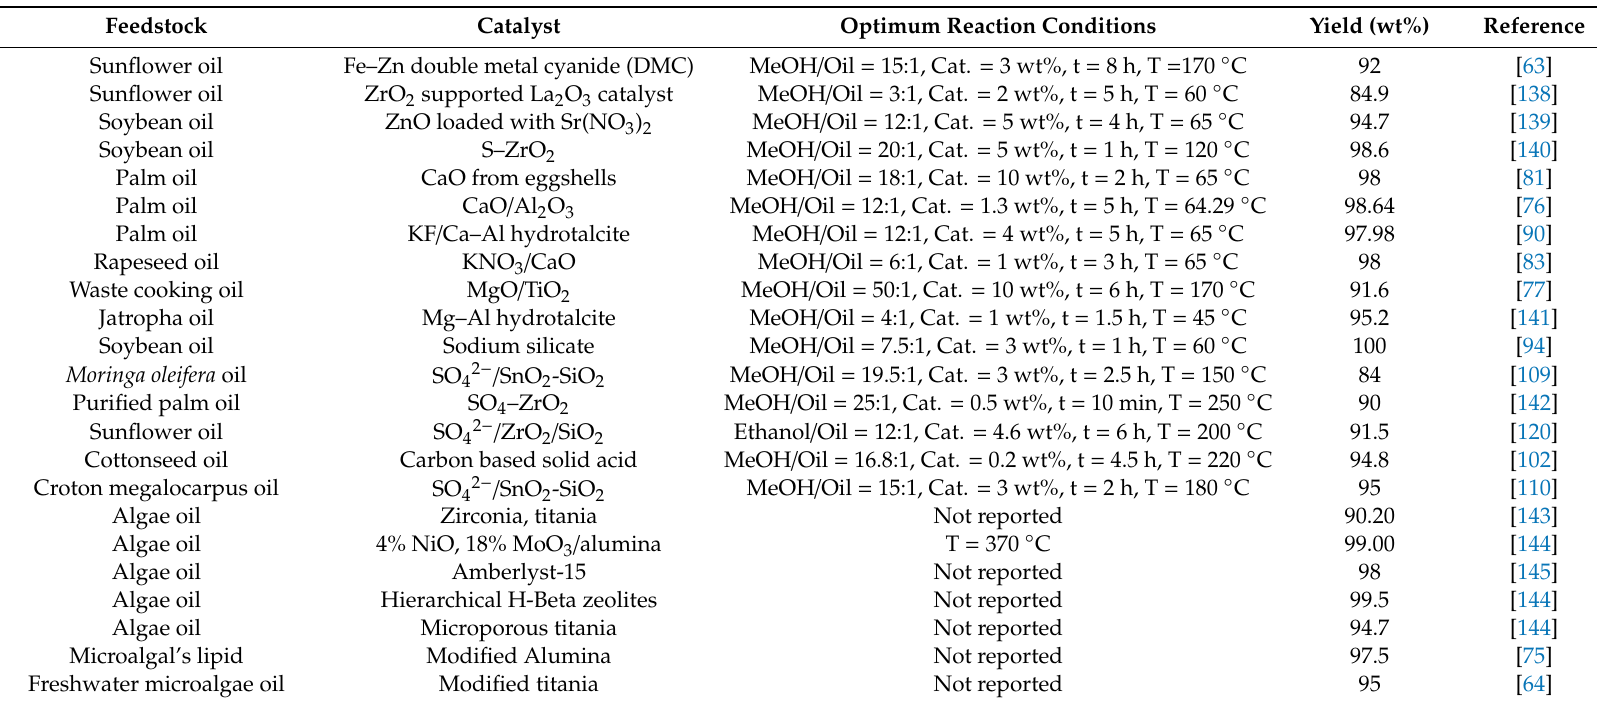
Table 4. Various heterogeneous catalysts for transesterification reaction: optimum parameter condition, feedstock, and biodiesel yield.